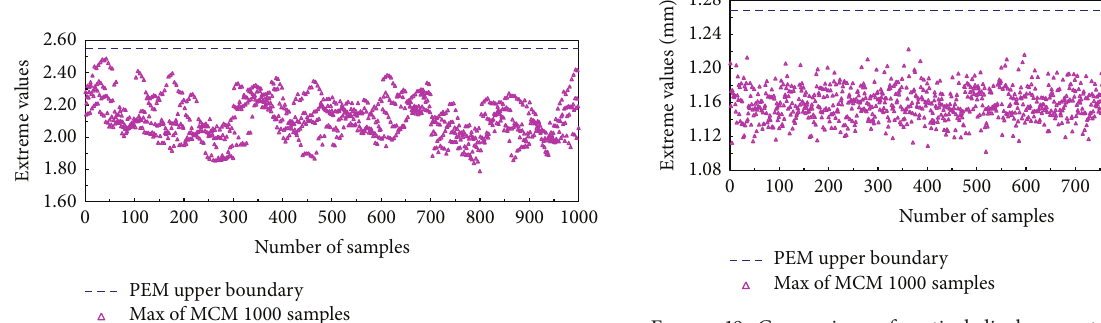
Figure 19: Comparison of vertical displacement of bridge girder midpoint.